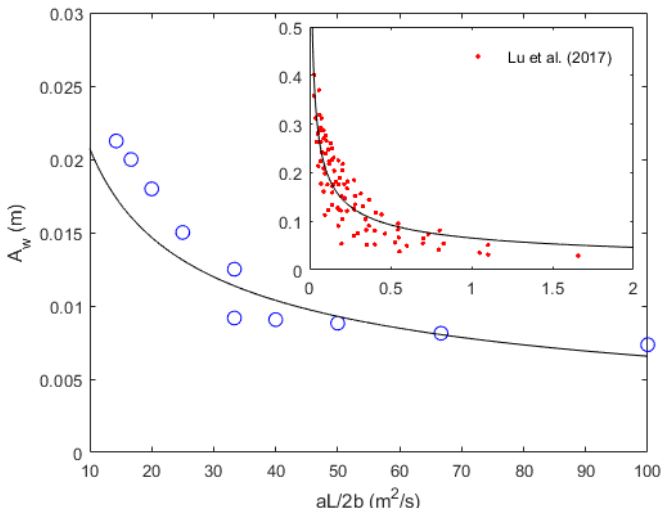
Figure 13. Wave amplitude, A w , as a function of volume flux of water displaced by per unit width of the moving bottom, aL /2 b . Circle: present numerical results. Line: fitted equation for A w given in (3). The upper corner subplot shows (3) along with the results used to produce (3) by Lu, Park & Cho